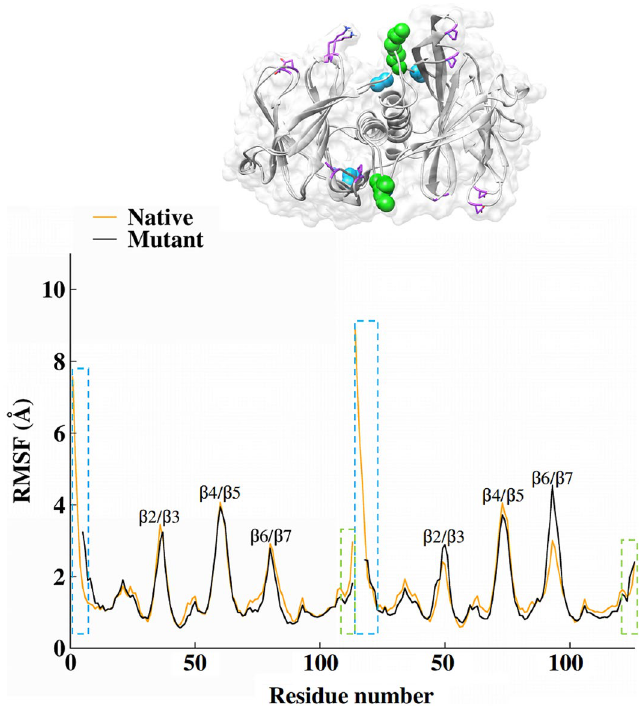
Figure 3. RMSF average of the residue fluctuations obtained along the 800–2000 ns MD simulation for the native (orange) and mutant (black) systems. Highlighting the final structures of the simulation with the N-terminal region (blue), C-terminal green), and residues with high fluctuations in the loops (purple) for both